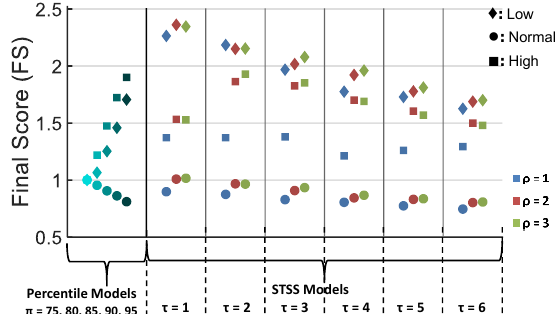
Figure 2. Average of Final Score values of different NRC detection models on different travel demand levels assuming equal weights for the evaluation criteria